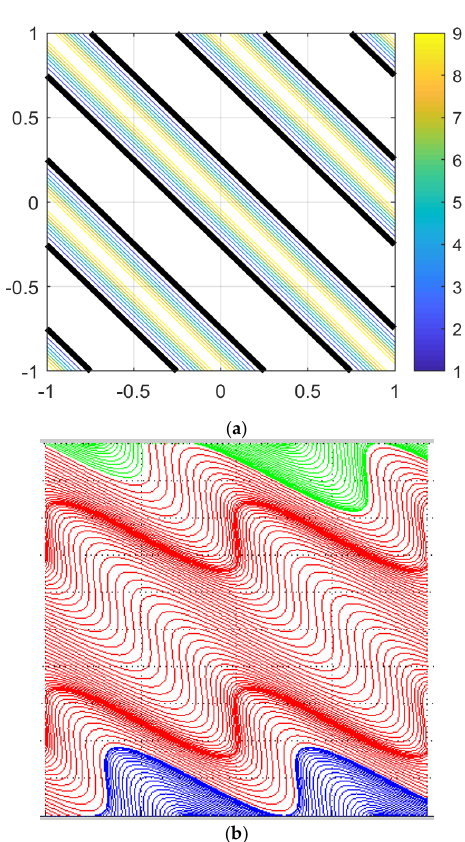
Figure 5. ( a , b ) Analytic Darcy flow problem with exponential-cosine permeability: permeability field, streamlines, and hydraulic head field, from top to bottom. ( a ): contours of the periodic permeability field K ( x , y ) with σ LnK ≈ 2.30; the bold black contours correspond to geometric mean permeability K G = 1; the broad white zones without contour lines correspond to the relatively flat minima of K ( x , y ) . ( b ): streamlines of the analytical Darcy velocity field ( v X ( x , y ) , v Y ( x , y )) given in the